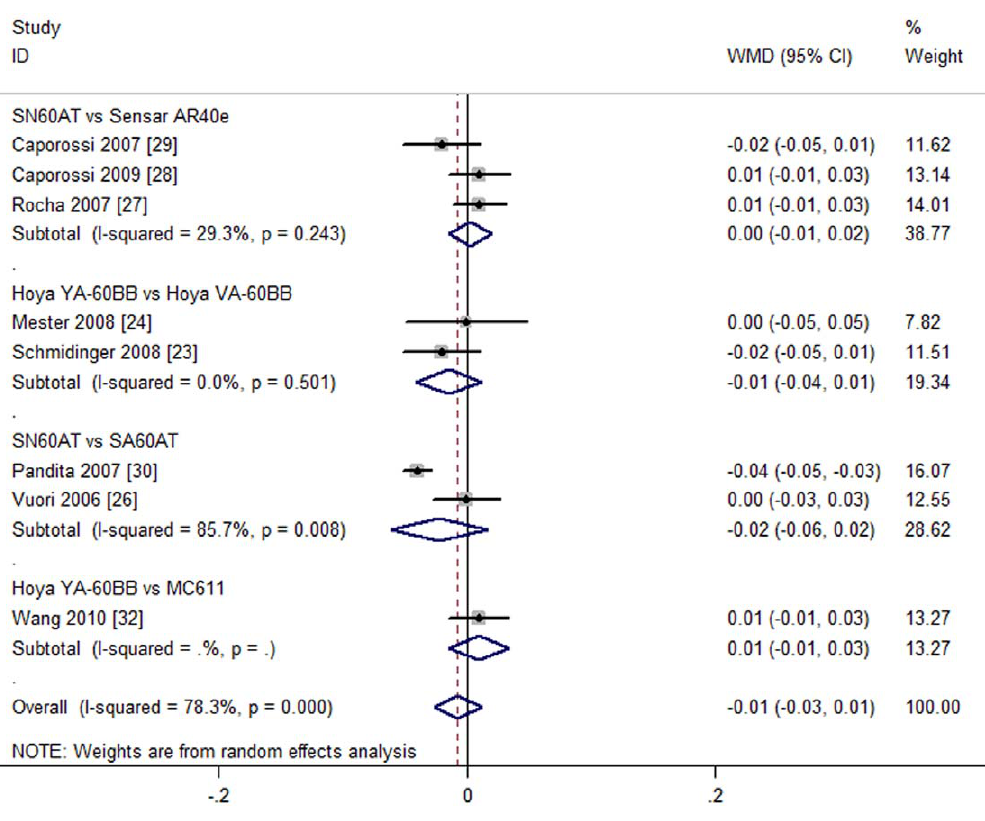
Figure 3. Subgroup analysis of postoperative best corrected distance visual acuity (BCVA).